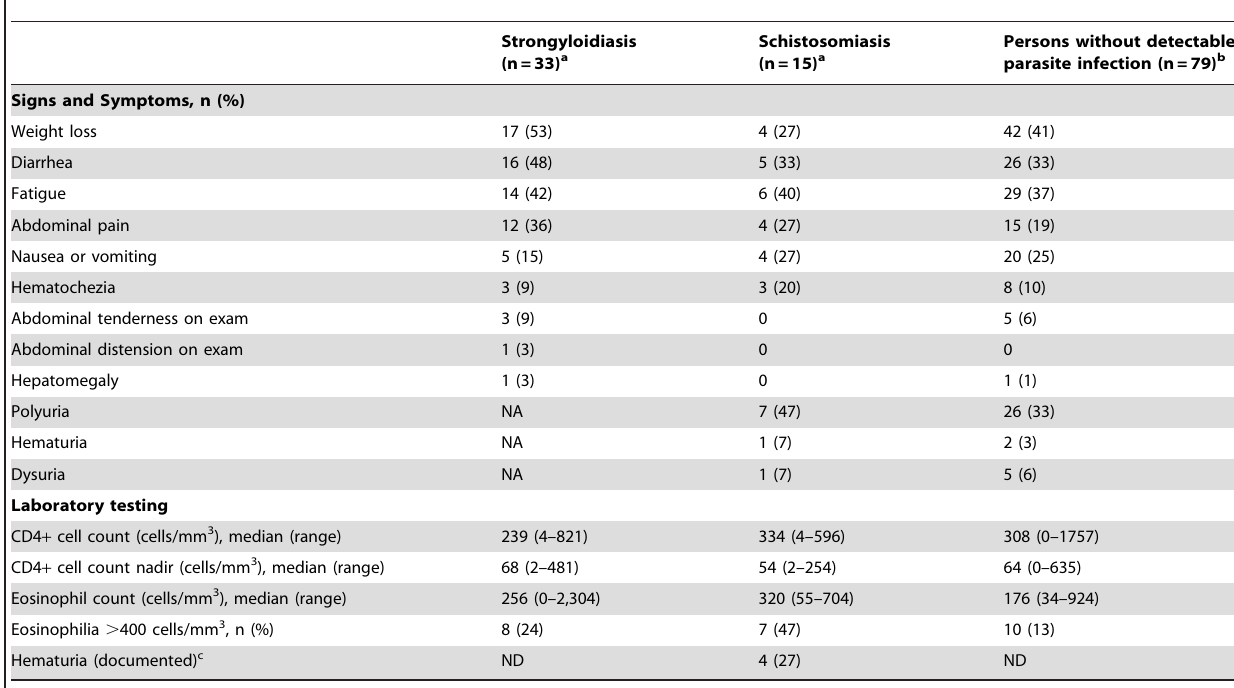
Table 2. Signs, symptoms, and laboratory findings of foreign-born, HIV-infected persons with and without parasite infection.